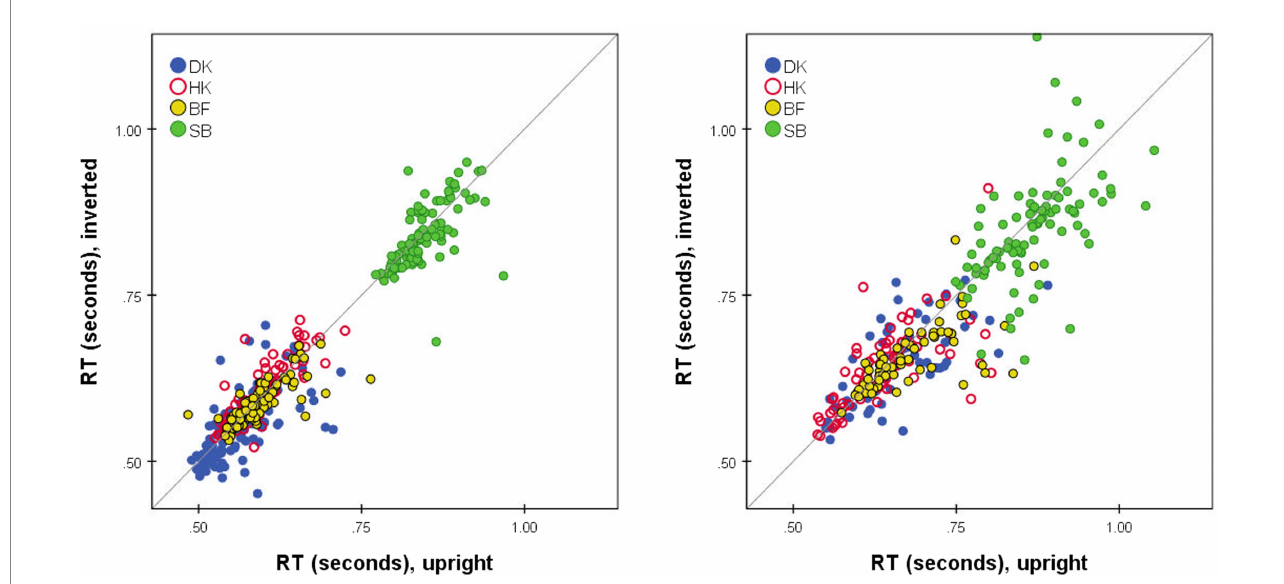
FIGURE 8 Median RT*( i , j ) for Upright pairs (horizontal axis) vs. Inverted pairs (vertical axis). M D ij for D responses (left); M S ij for S responses (right). Superimposed results for four observers. Pairs omitted if four or fewer responses in either presentation